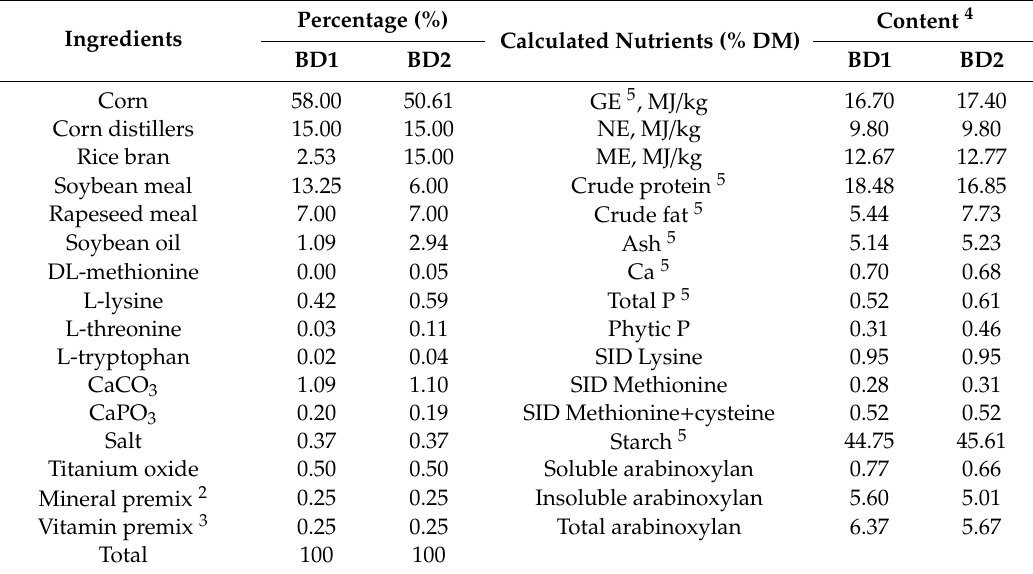
Table 1. Ingredients and nutritional compositions of basal diets 1